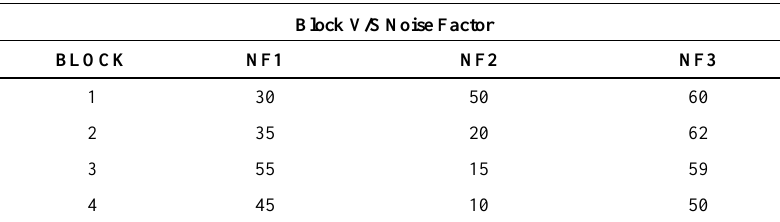
Table 6. Data for